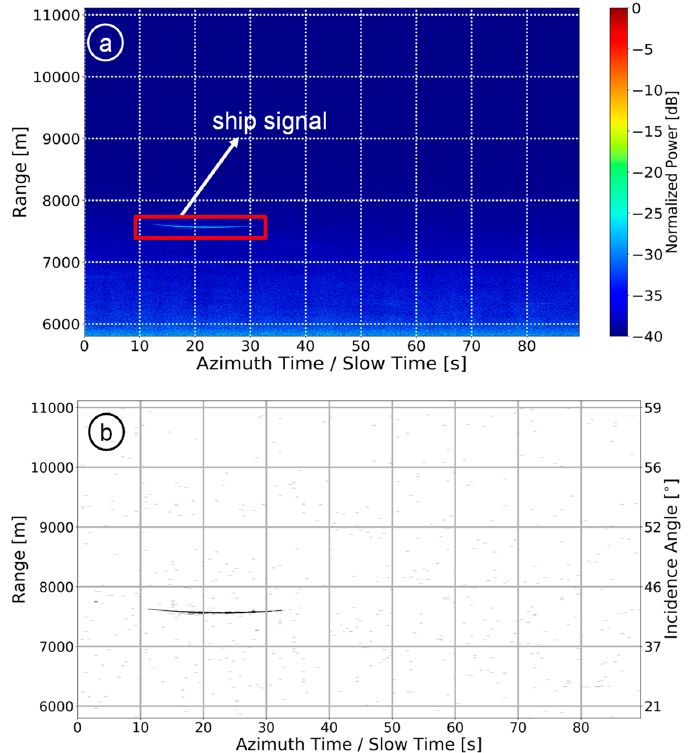
Figure 29. ( a ) Linearly acquired real single-channel HH polarized RC X-band radar data. ( b ) Corresponding binary detection map shown in time-domain after applying CFAR based ship detection in range–Doppler domain. K-Rayleigh distribution function was used in the near and mid ranges, and the 3MD model was used in the far range of the data. The desired false alarm rate was set to P fa = 10 − 6 . The detected ship signal is clearly visible in the RC data and in the detection map. Remote Sens. 2018 , 10 , x FOR PEER REVIEW